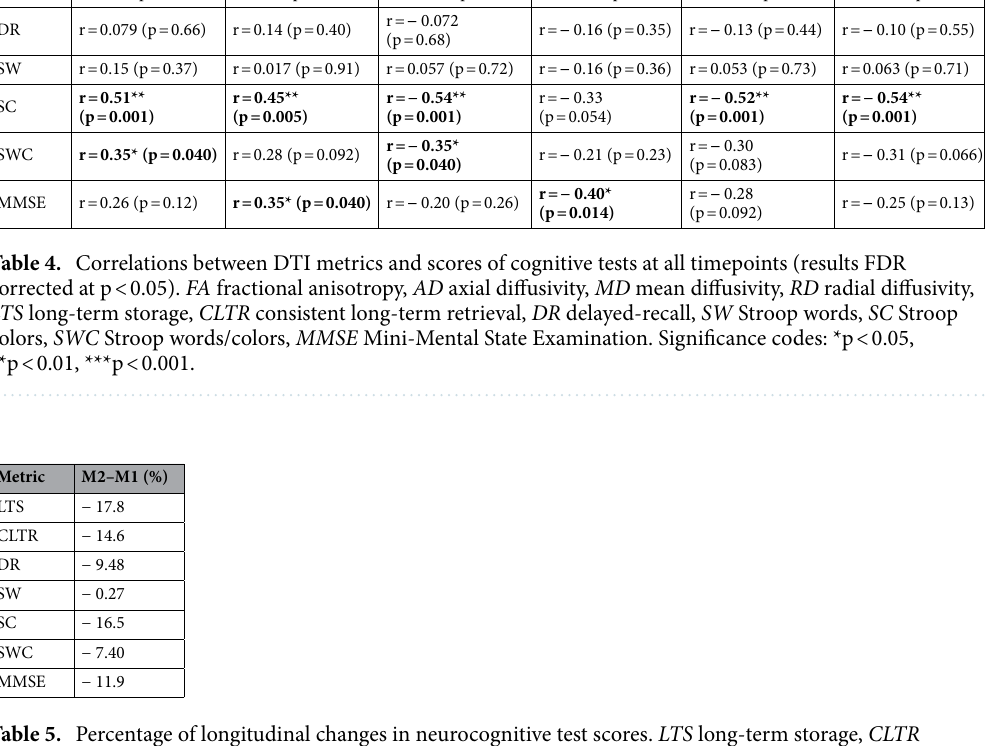
Table 5. Percentage of longitudinal changes in neurocognitive test scores. LTS long-term storage, CLTR consistent long-term retrieval, DR delayed-recall, SW Stroop words, SC Stroop colors, SWC Stroop words/ colors, MMSE Mini-Mental State Examination, M1 timepoint 1, M2 timepoint